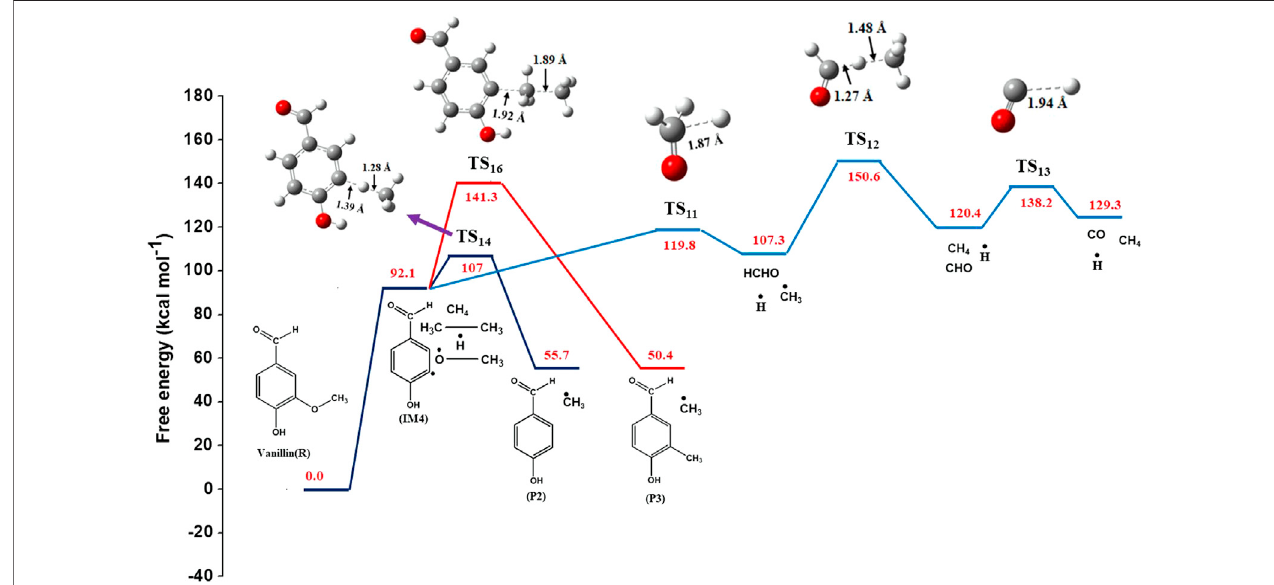
FIGURE 6 | Potential energy pro fi le for the transformation of vanillin to 4-hydroxybenzaldehyde.